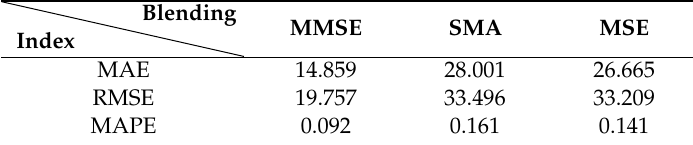
Table 4. Evaluation of blending technique using radar data.